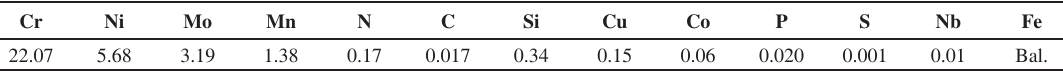
Table 1. Chemical composition (wt%) of the studied